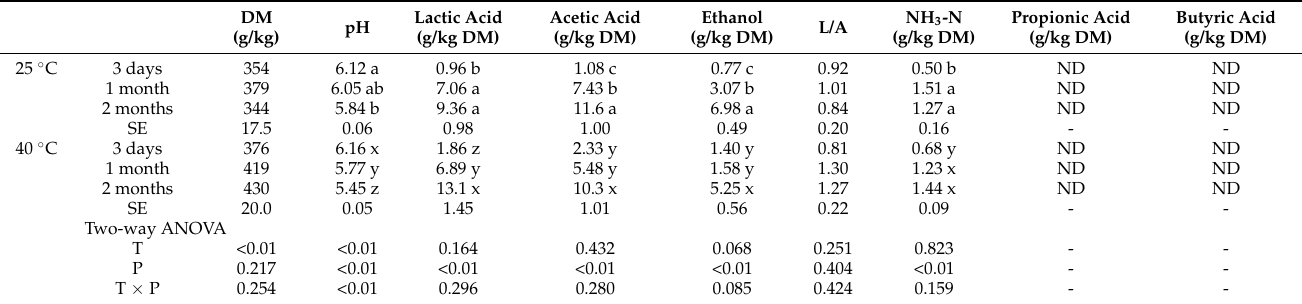
Table 2. Dry matter, pH value, and fermentation products of wilted guinea grass silage stored at 25 and 40 ◦ C for 3 days, 1 month, and 2